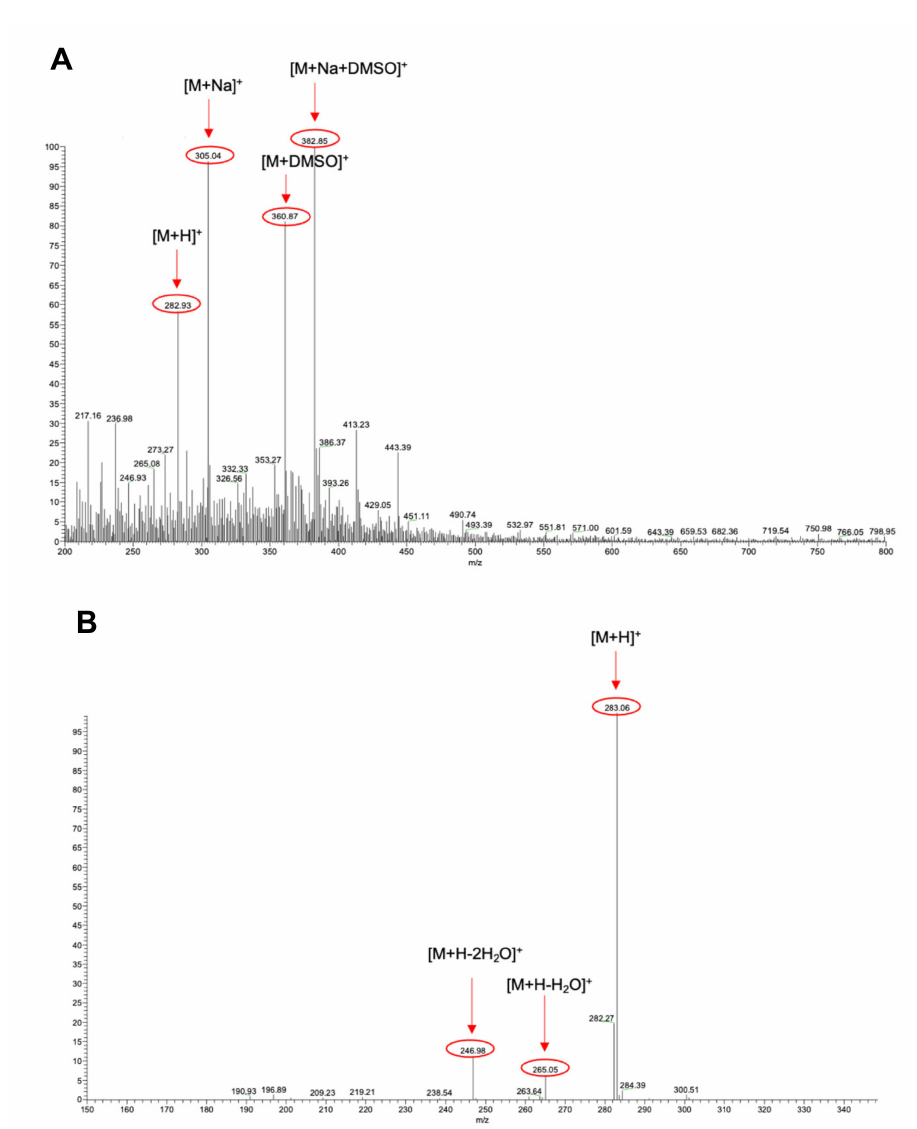
Figure 4. ESI-MS spectra of the sample manually collected from HPLC-DAD of the ART. ( A ) Full ESI-MS spectrum. ( B ) Fragmentation spectrum resulting from the CID experiment carried out on the isolated signal at m/z = 283.12 (normalized collision energy =